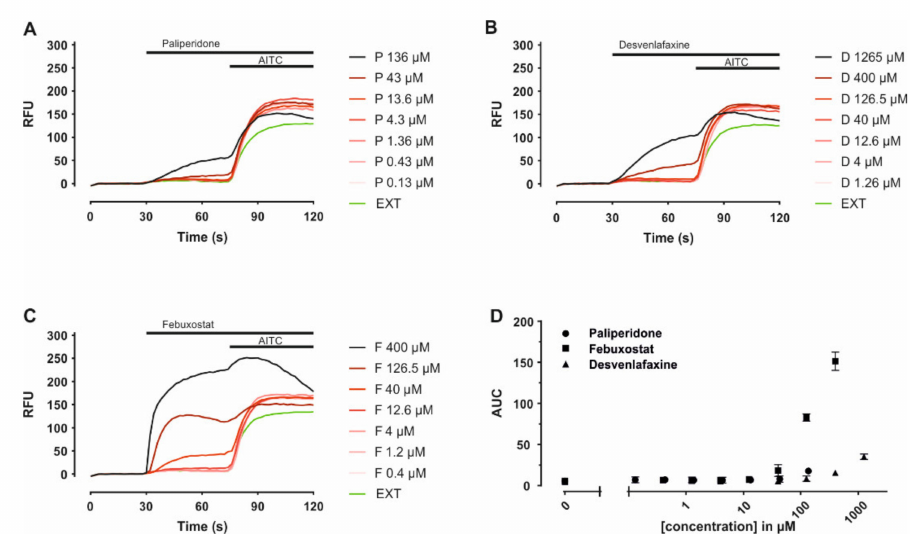
Figure 4. Paliperidone, desvenlafaxine and febuxostat effects in hTRPA1 expressing HEK293T cells. ( A – C ) Individual time courses of fluorescence displayed as means of 3 replicates for each given concentration. ( D ) Area under the curve calculated for the interval 30–70 s, reflecting the addition of the compounds until the addition of